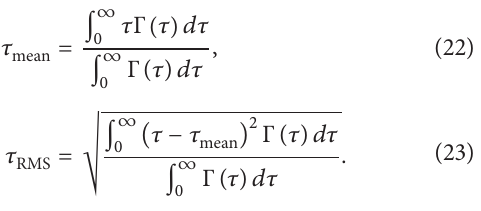
Γ represents the power of the echoes and 𝜏 their delay relative to